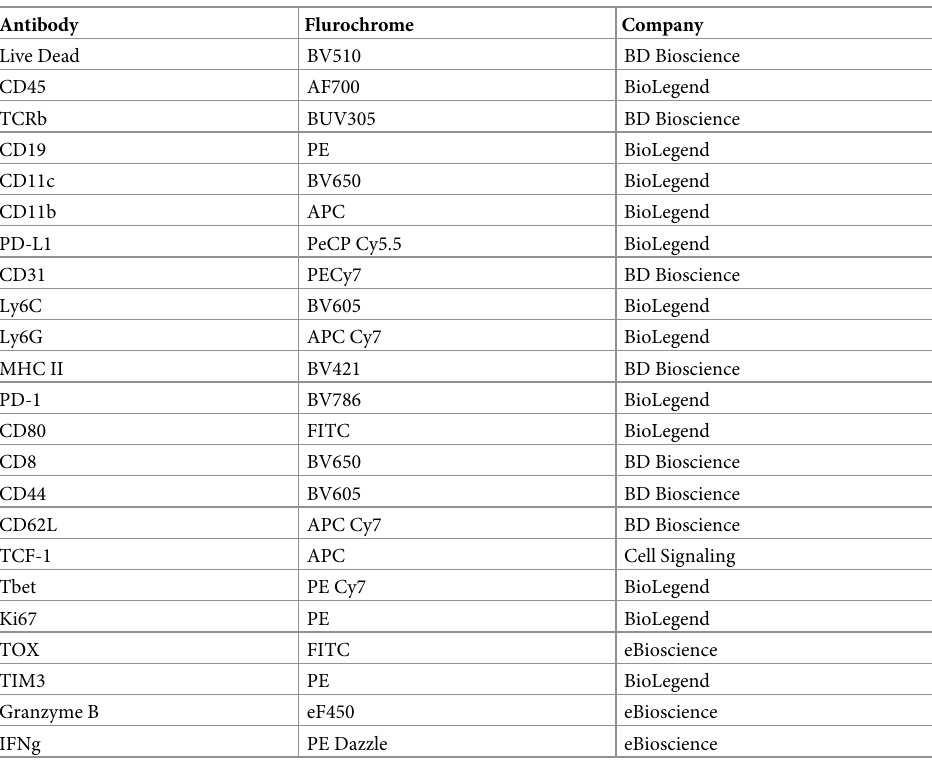
Table 1. Antibody list used for cytometry staining.